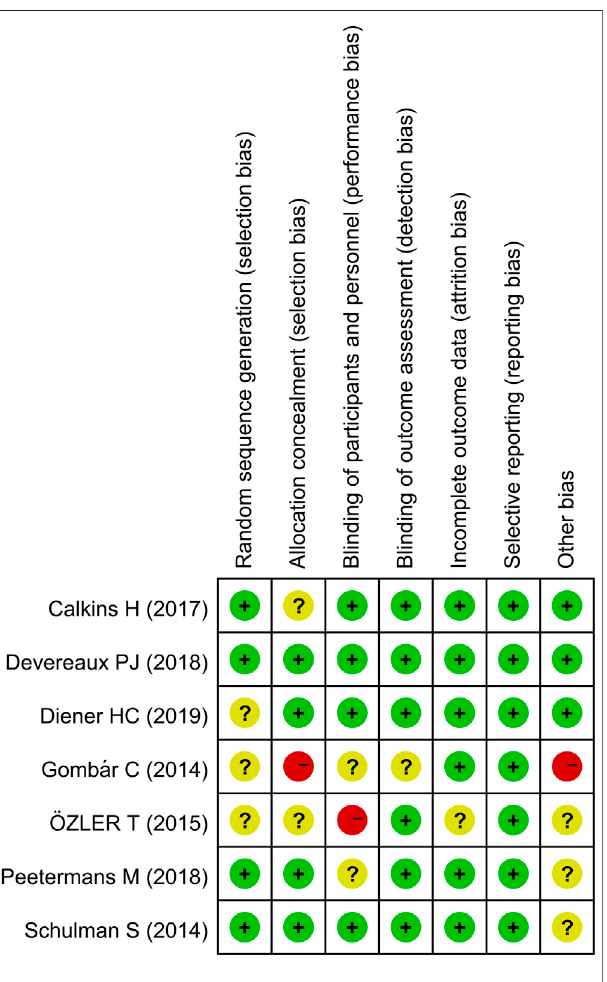
FIGURE 2 | Summary of risk of